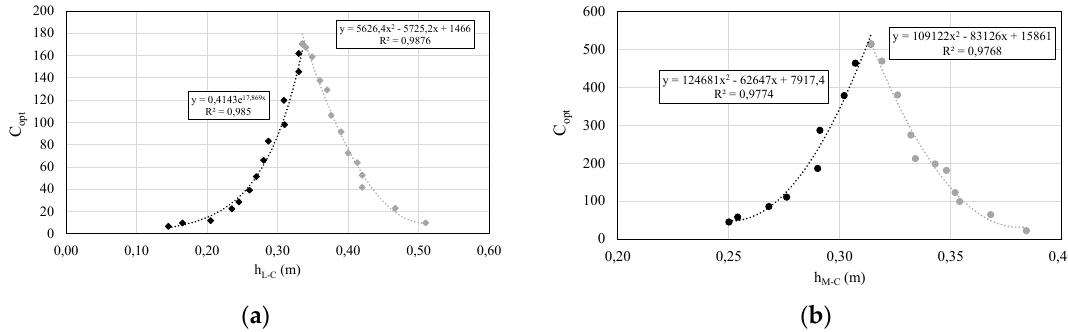
Figure 3. Trends of C opt as function of the distance between optics and receiver in the case of Fresnel lens ( a ) and spherical mirror ( b ) in the presence of secondary optics.